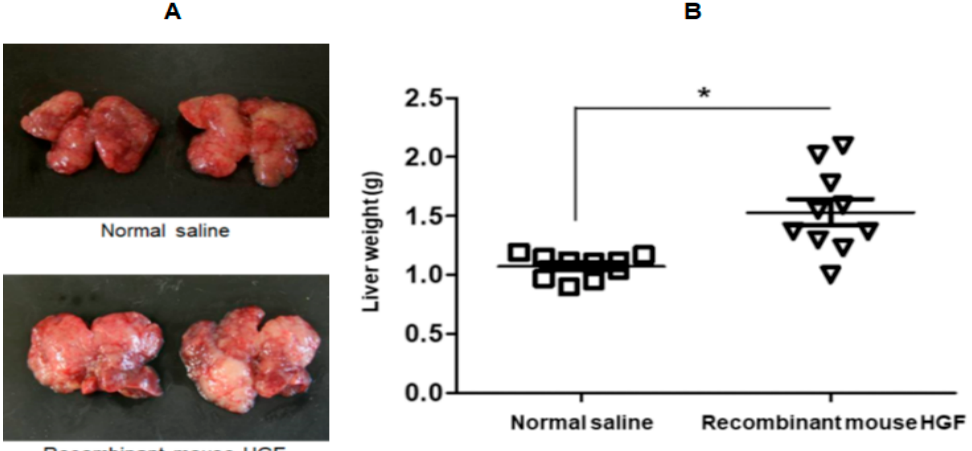
Figure 5. Intraperitoneal injection of recombinant mouse HGF significantly promoted liver metastases. ( A ): Representative image of macroscopic liver metastases on day 14 are depicted. ( B ): The liver weights 14 days after intraperitoneal injection of recombinant mouse HGF (n = 10) or normal saline (n = 10) in the murine liver metastasis model.